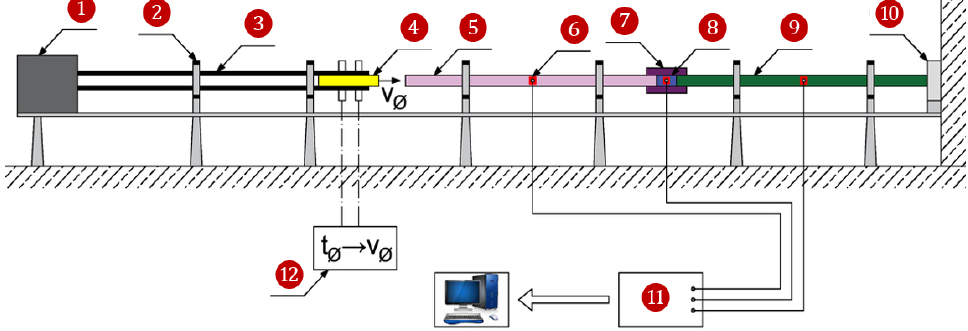
Figure 5. SHPB test stand diagram with designations of important components (cid:182) –